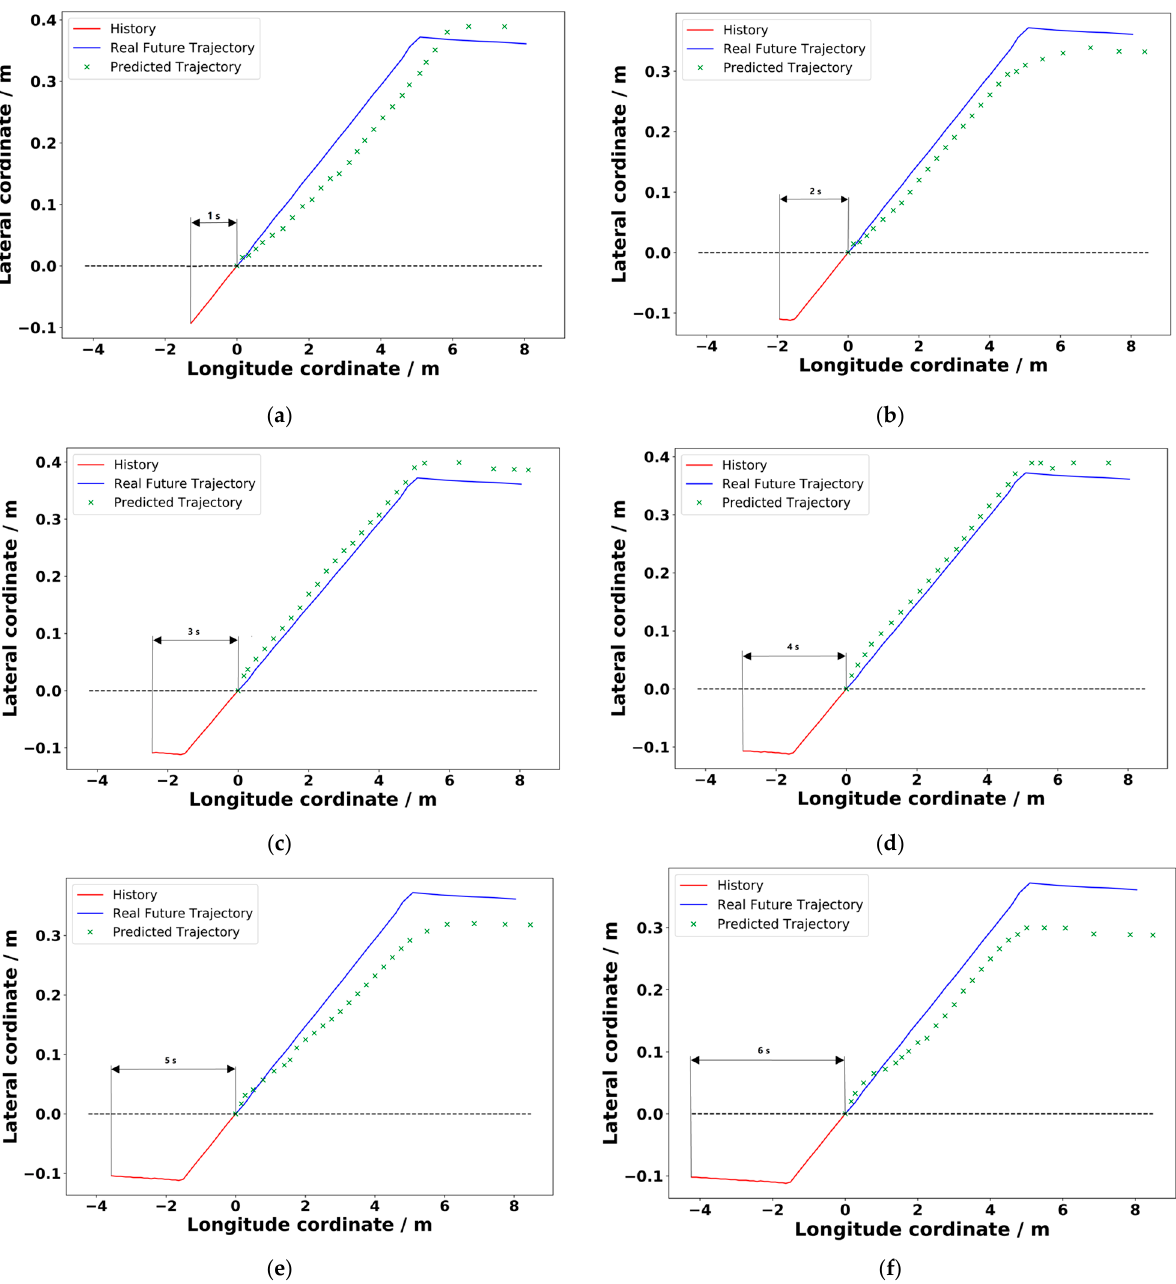
Figure 6. Comparison of prediction results of RA-LSTM model with different lengths of input history trajectories. ( a – f ) represent the comparison of the prediction results of the input historical trajectory within 1 s, 2 s, 3 s, 4 s, 5 s, 6 s, Table 3. Comparison of historical trajectory model errors of each length.